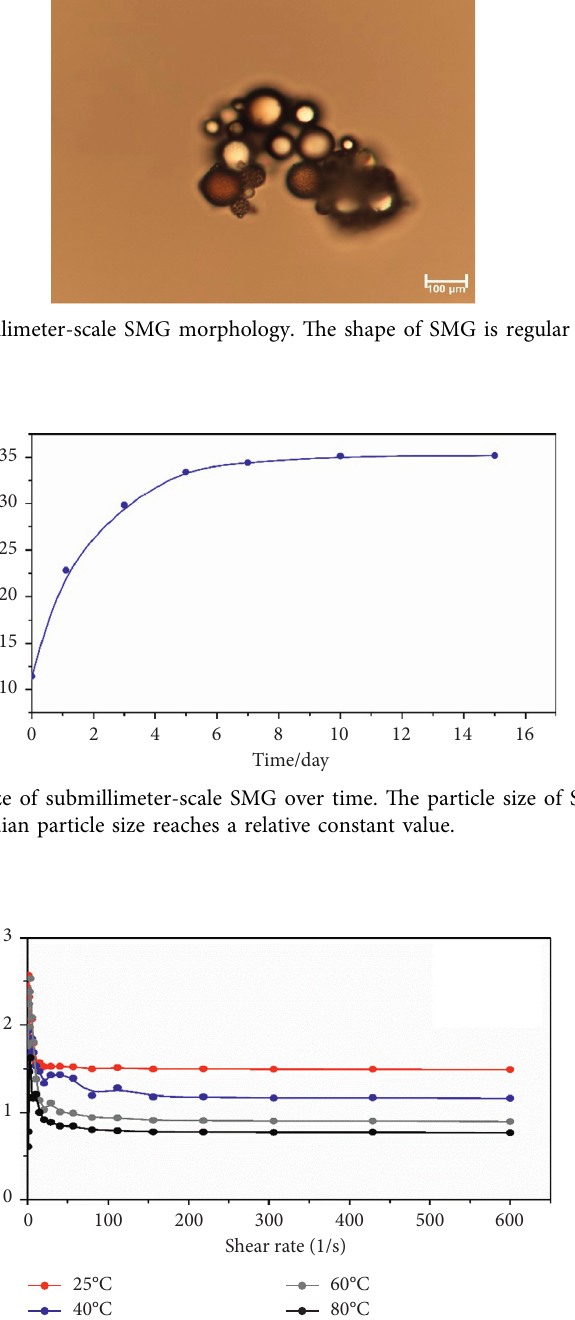
Figure 5: The rheological curve of submillimeter-scale SMG. It is characterized by low viscosity and shear resistance, with a viscosity of only 0.8 ～ 2.6mPa ·